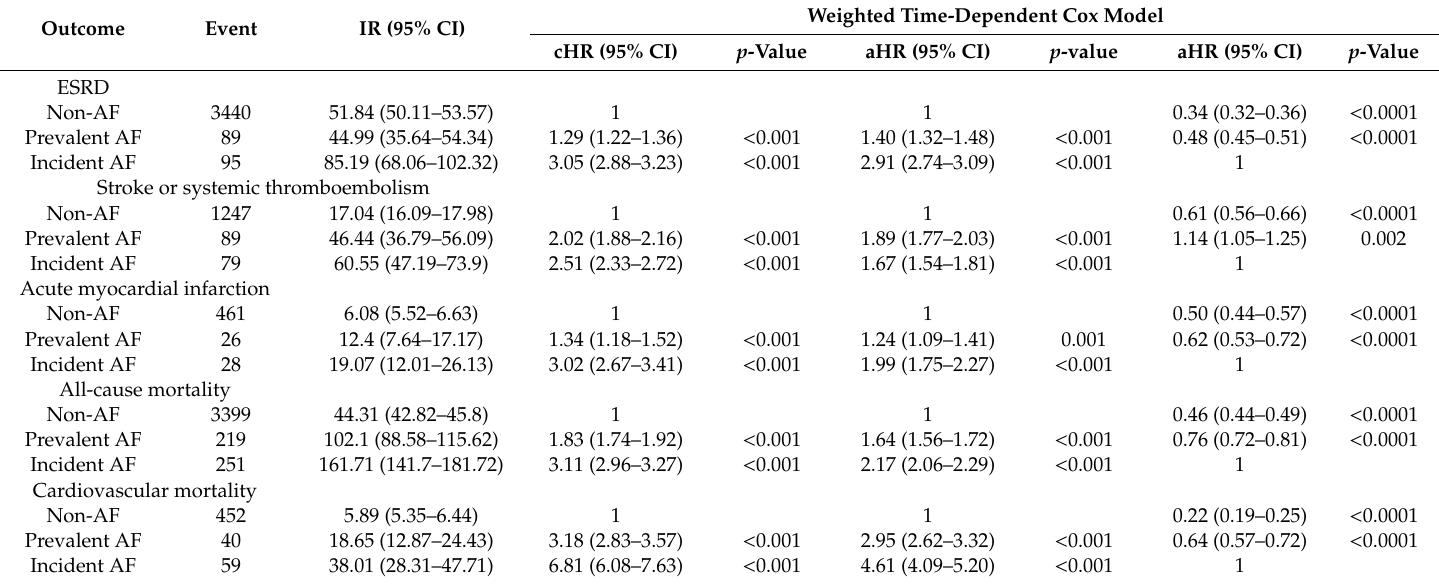
Table 2. Risks for end-stage renal disease (ESRD), stroke or systemic thromboembolism, acute myocardial infarction (AMI), and mortality among patients with CKD by AF